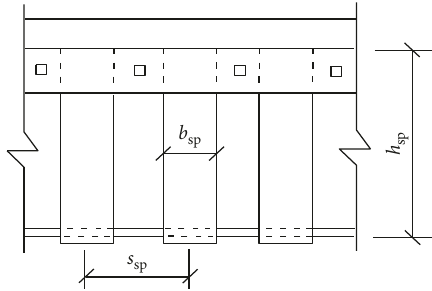
Figure 5: Schematic diagram of the hoop plate